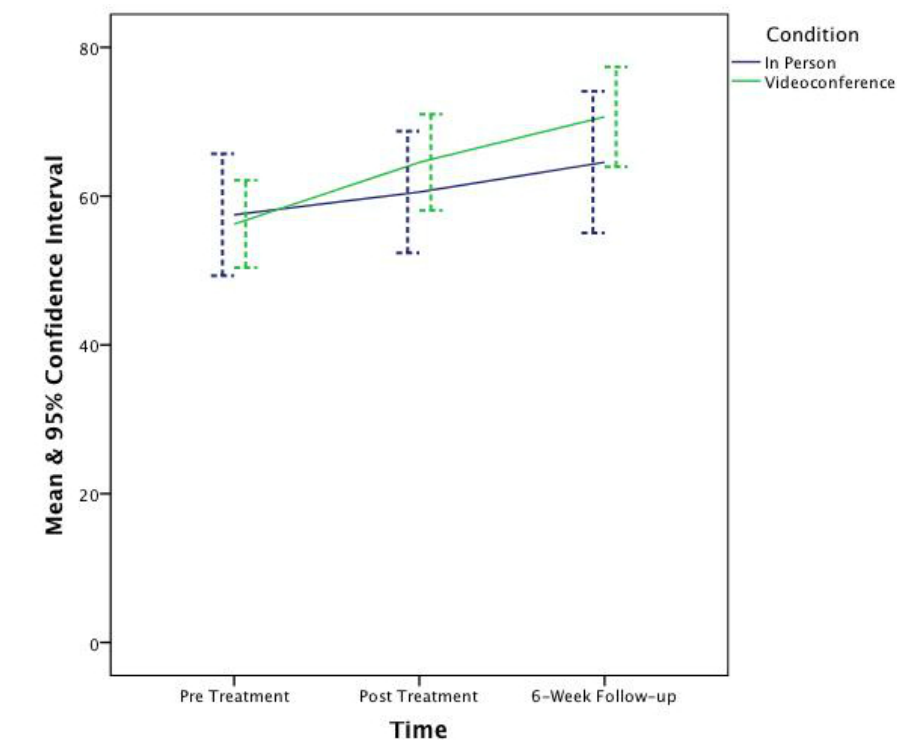
Figure 5. The change in quality of life across time and